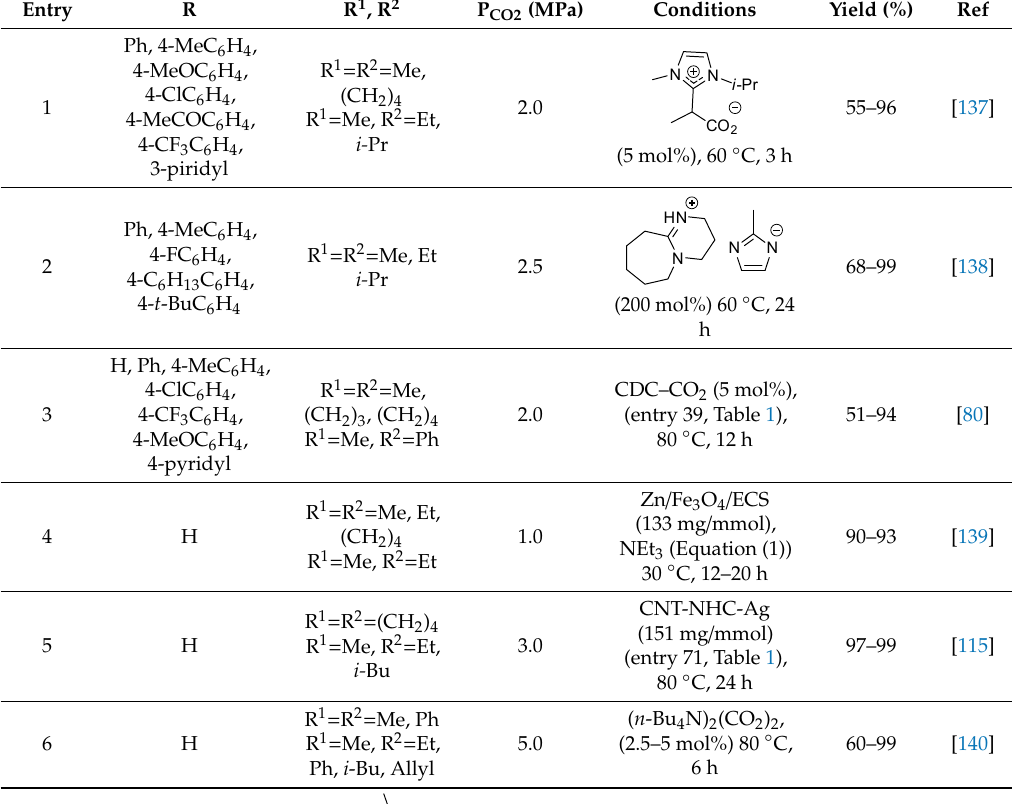
Table 2. Catalysts for the reaction of propargyl alcohols and carbon dioxide (R, R 1 and R 2 see Scheme 10).